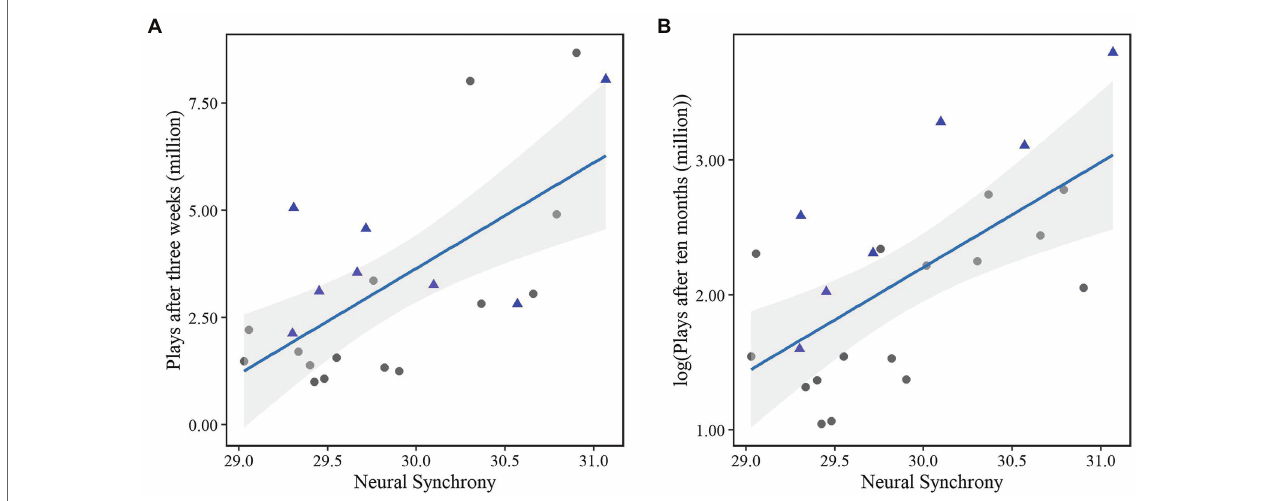
FIGURE 1 | The distribution of singles across neural synchrony and plays (A) after either 3 weeks or (B) after 10 months log transformed. The blue line indicates the fitted regression line. The gray area indicates the confidence interval. The promotional single releases are indicated by blue